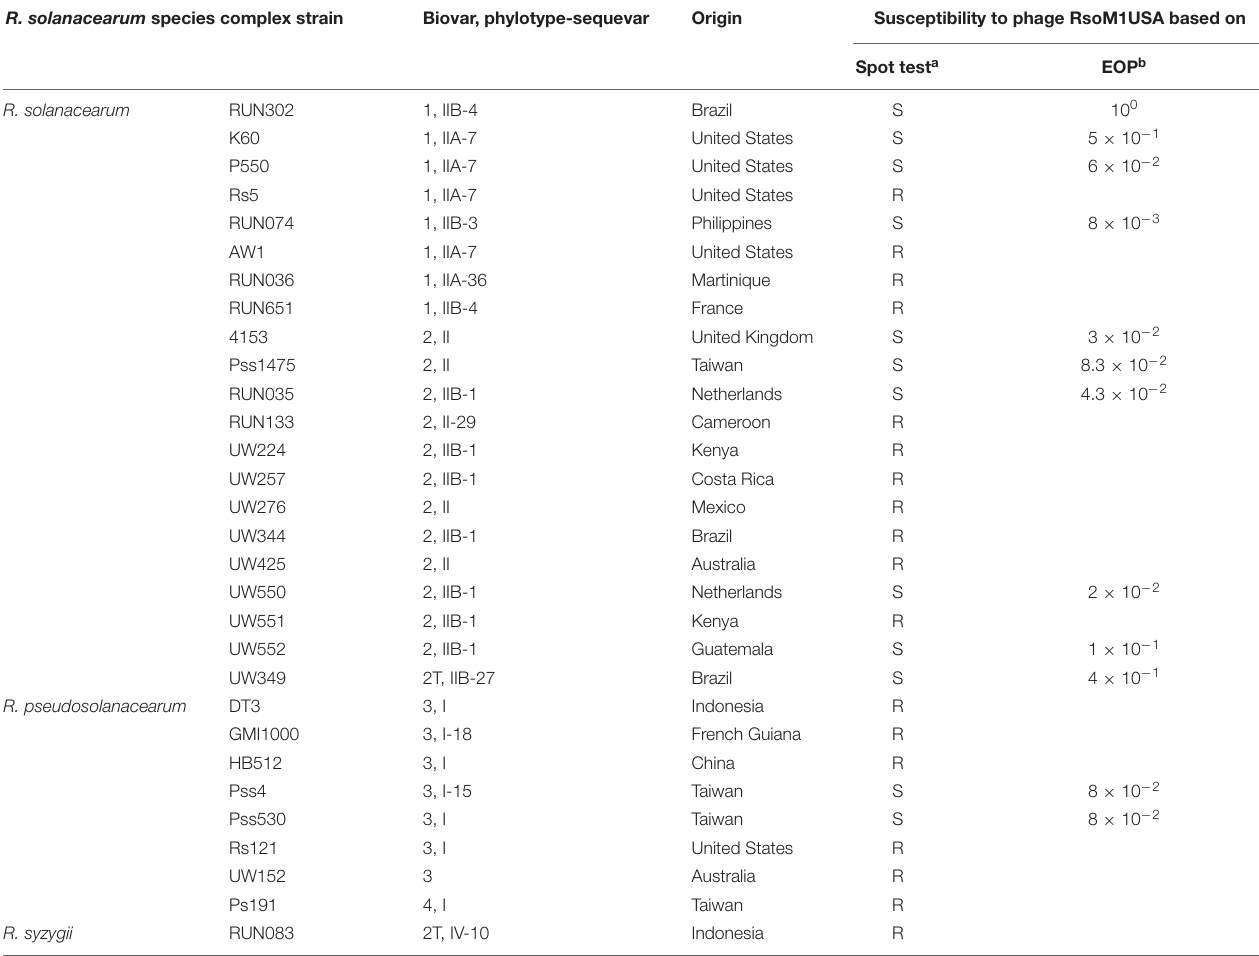
TABLE 1 | Susceptibility of R. solanacearum species complex strains to phage